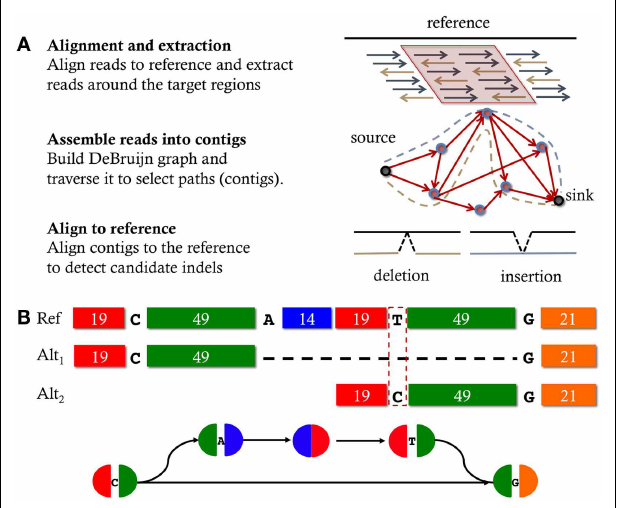
FIGURE 1 | Micro-assembly. (A) typical workflow of the micro-assembly strategy: given a specific region of interest, the reads, previously aligned to the reference, are extracted, assembled, and then contigs are aligned back to the reference to discover mutations. (B) Schematic representation of a bubble in a De Bruijn graph induced by a heterozygous mutation within a repetitive sequence composed of two near-identical copies (with 1bp mismatch) that are 15bp apart. Each block represents a sequence; sequences that have the same base pair composition have the same color; the length of each sequence (in base pairs) is reported inside each block. Each node of the graph is colored according to the order and sequence composition contained in it. Simple (non-branching) paths are represented in a single node. Alt1 and Alt2 are two alternative alignments of the sequence contained in the bottom side of the bubble, where the dashed line represents the alignment gap.The top side of the bubble matches the reference. Any k -mer longer than the longest identical repeat ( > 49bp) and shorter than the longest near-identical repeat ( < 69bp) would create a bubble like the one depicted (B) where a jump is allowed from the first copy of the near-identical repeat to the second